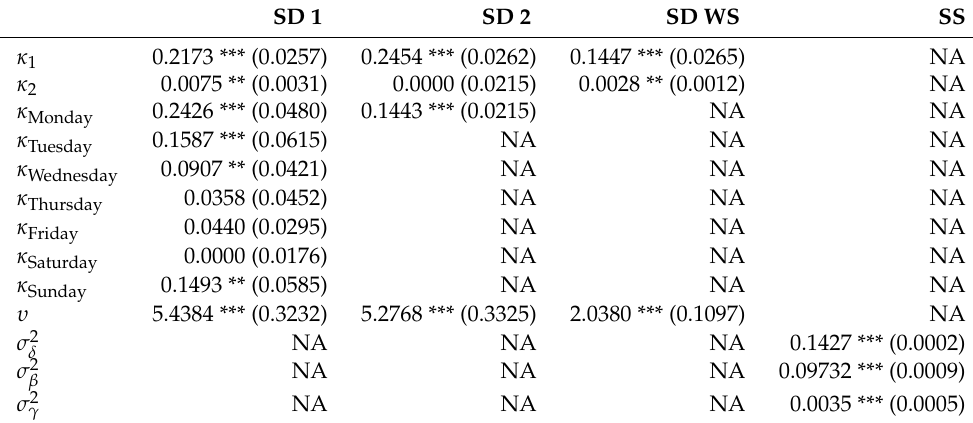
Table A7. Parameter estimates for Guatemala.